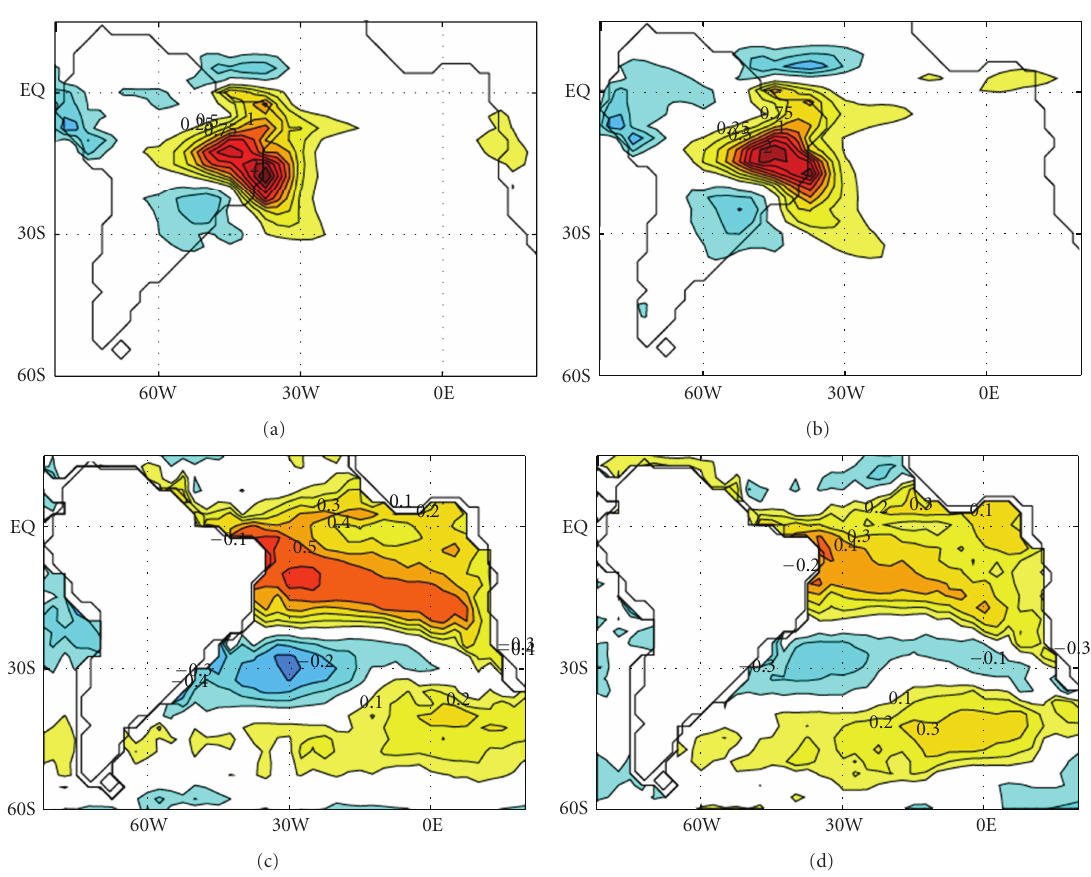
Figure 5: EOF1 in period P1 (a) and period P2 (b); contour interval: 0.25 mm/day. Correlation between the time series of EOF1 and SST anomalies in period P1 (c) and period P2 (d); contour interval: 0.1. Correlation values higher (lower) than 0.2 ( − 0.2) are significant at a 5% level according to a two-tailed Student t -test.